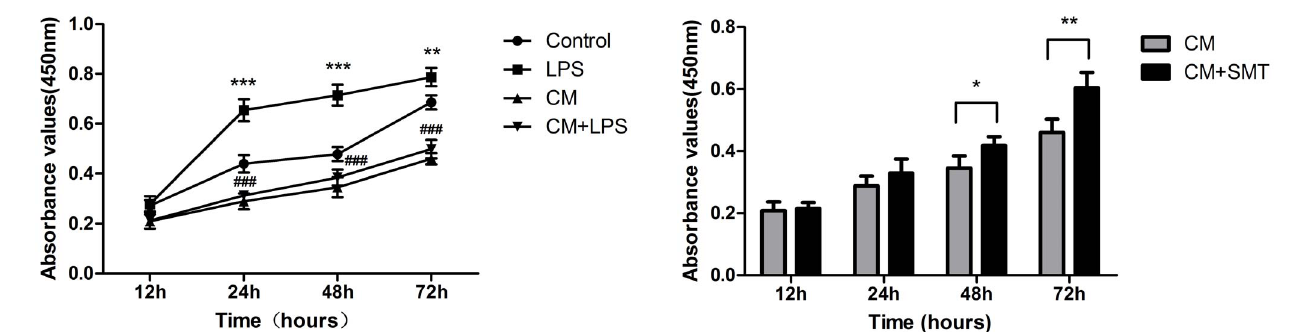
Figure 2. Role of NO in the BMSC-mediated inhibition of microglial proliferation. We cultured microglia in conditioned medium derived from BMSCs with or without inhibition of NO production. In the CM + SMT groups, microglia were incubated in conditioned medium derived from BMSCs in which NO production was inhibited by the NO inhibitor S-methylisothiourea sulfate (SMT, 1 mM). We found that cells cultured in CM after inhibition of NO production (CM + SMT groups) showed increased proliferation compared to cells cultured in CM without inhibition of NO production (CM groups). Bars represent means plus or minus SD obtained from six independent experiments. A P value of less than 0.05 (*), or less than 0.01 (**) was considered statistically significant.